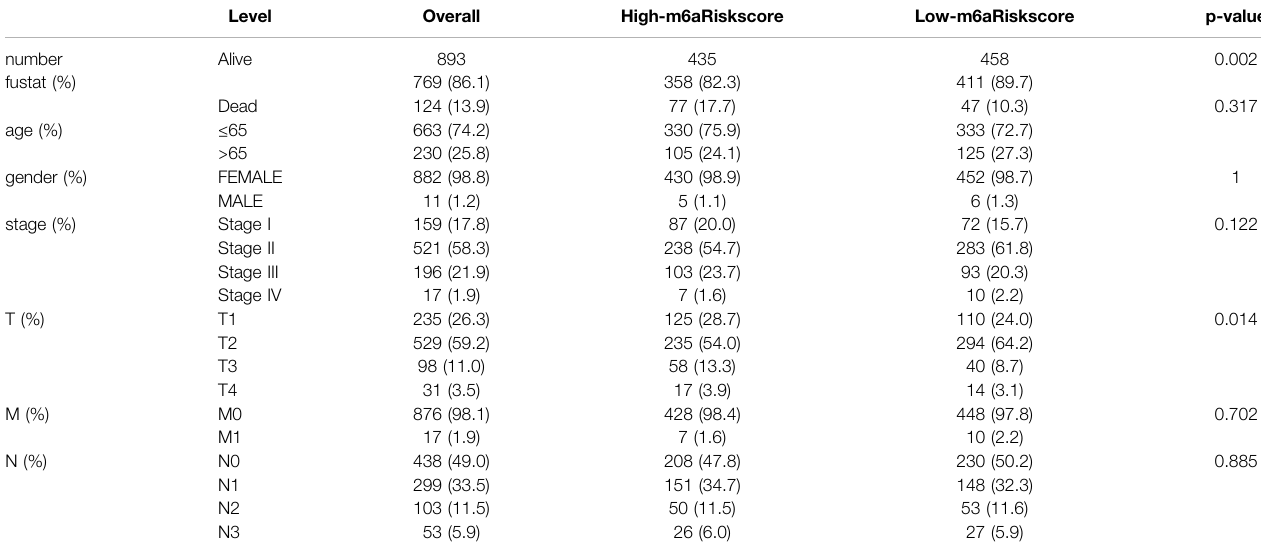
TABLE 1 | Clinicopathological features of patients included in this study annotated from TCGA database. Level